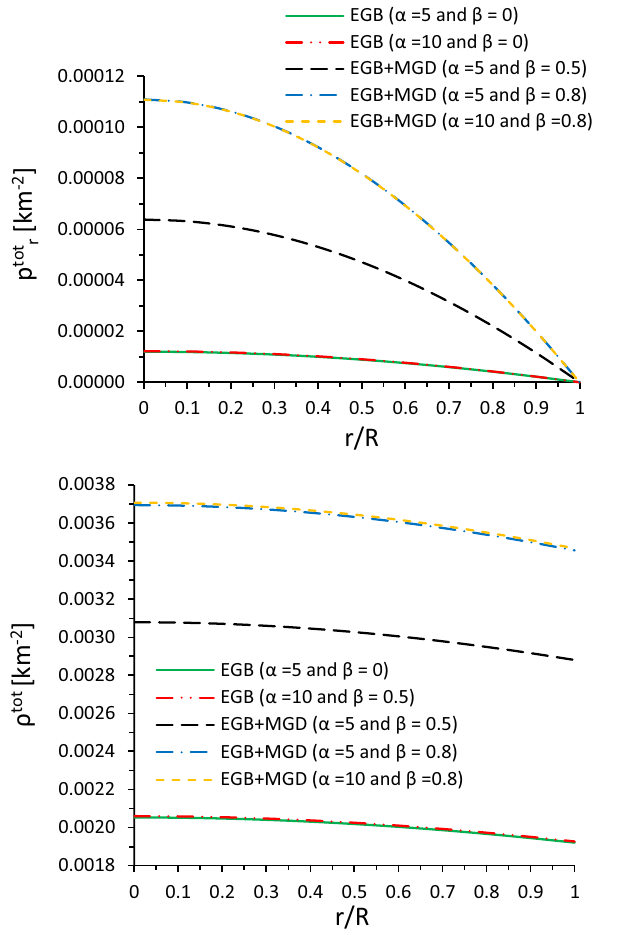
the total energy density ( ρ tot ) and the right panel shows the total radial and tangential pressures with respect to r / R . Here, we use the same set of parameters as of Fig.